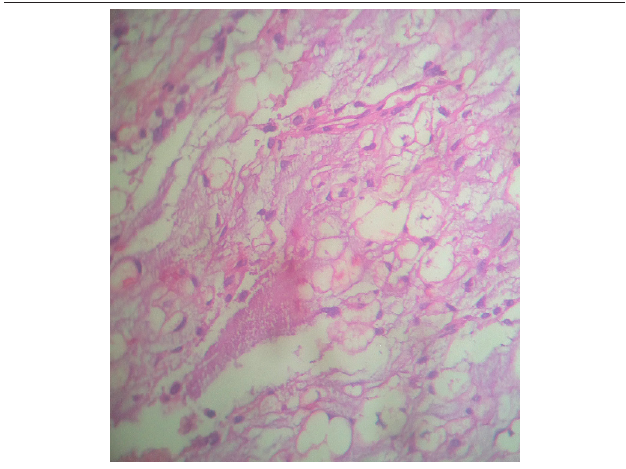
fIgure 3 – Photomicrograph (HE stain): presence of neoplasm with an extensive chondro-myxoid matrix HE: hematoxylin and